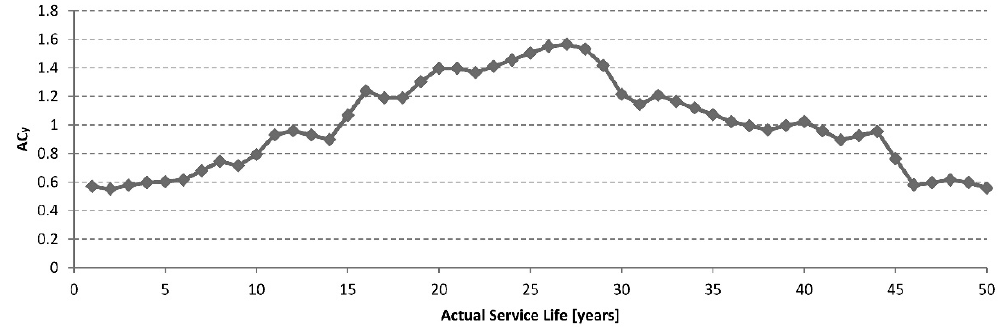
Fig. 2. Age coefficient ( AC ) vs. actual service life of a clinic for a DLC of 50 years y